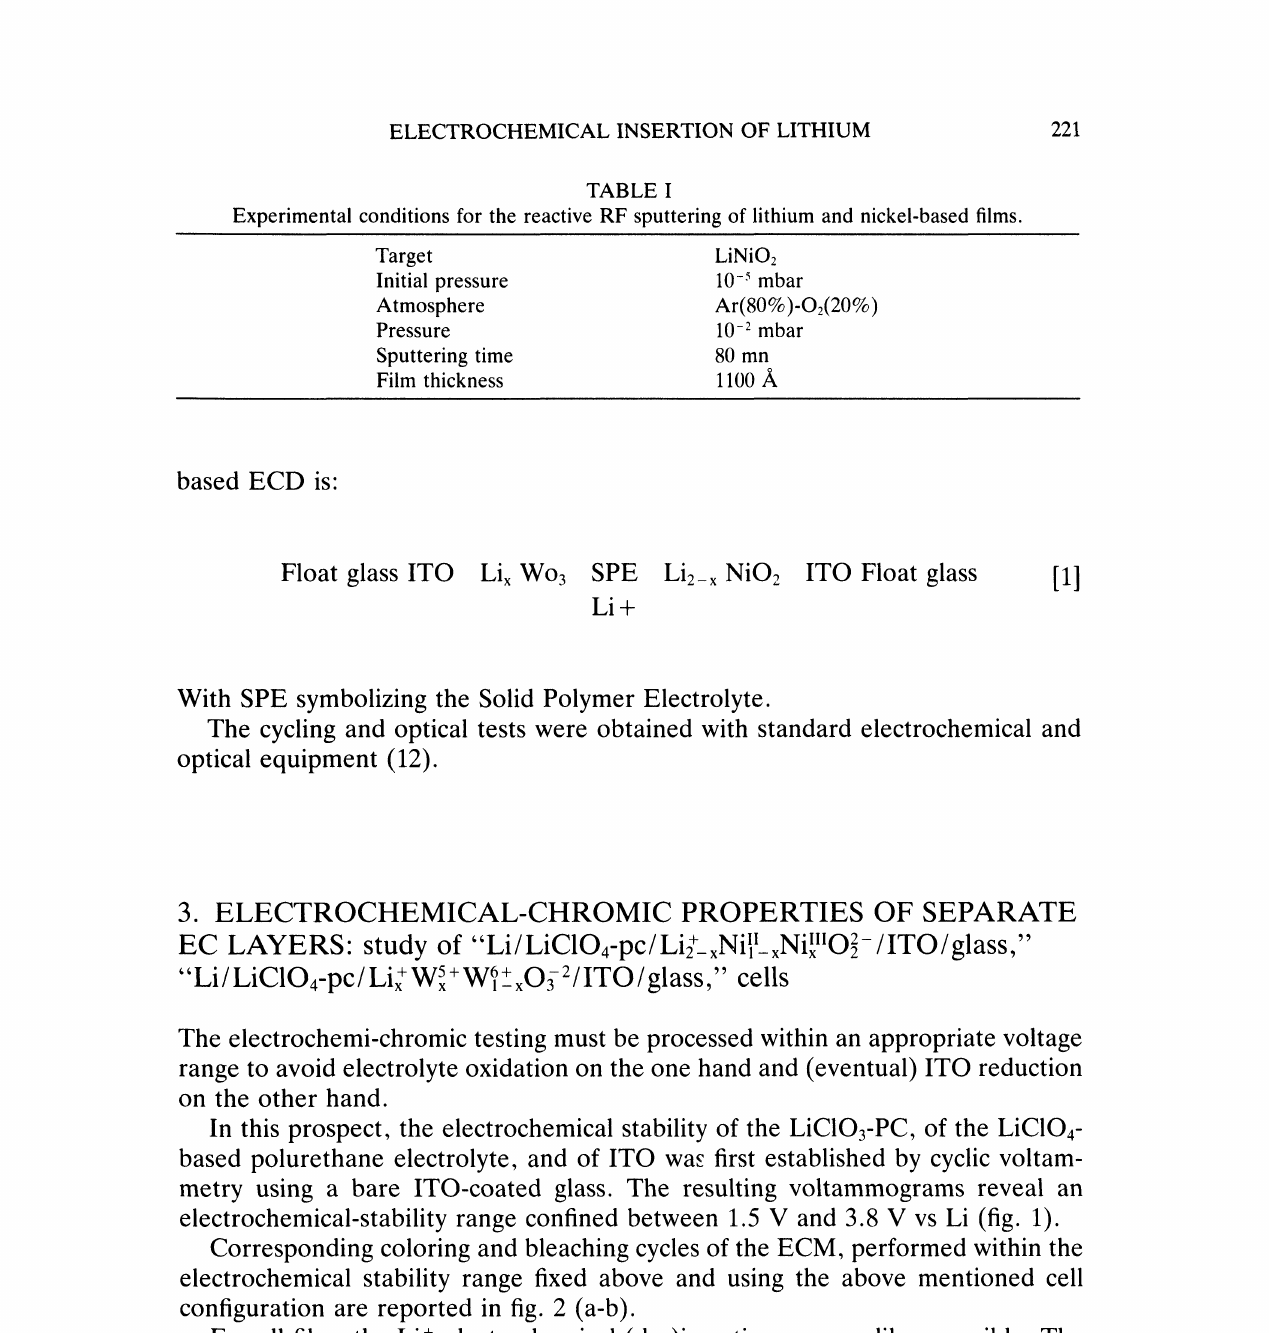
Experimental conditions for the reactive RF sputtering of lithium and nickel-based